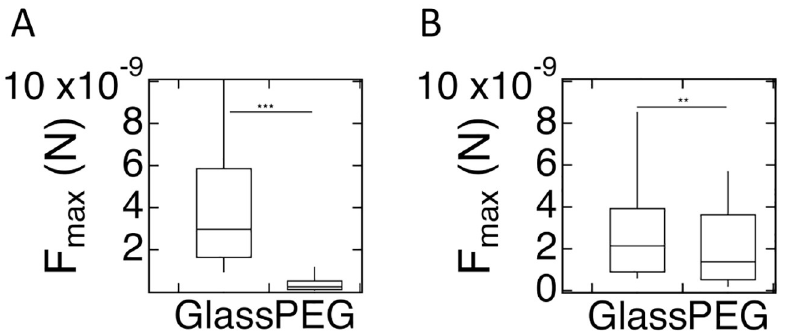
Fig 8. SCFS results for vegetative WT cells. F